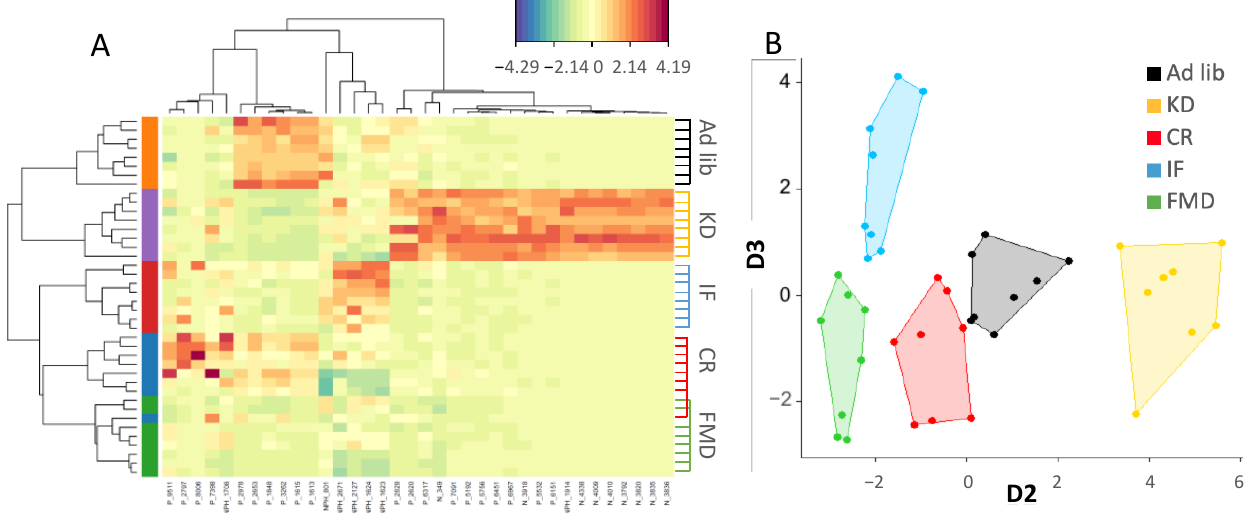
Figure 4. KD plasma metabolome composition is distinct from other restrictive diets. Plasma metabolome indicated clustering of metabolites specific to each diet ( A ), and PLS analysis ( B ) confirmed distinct features separating the diets.